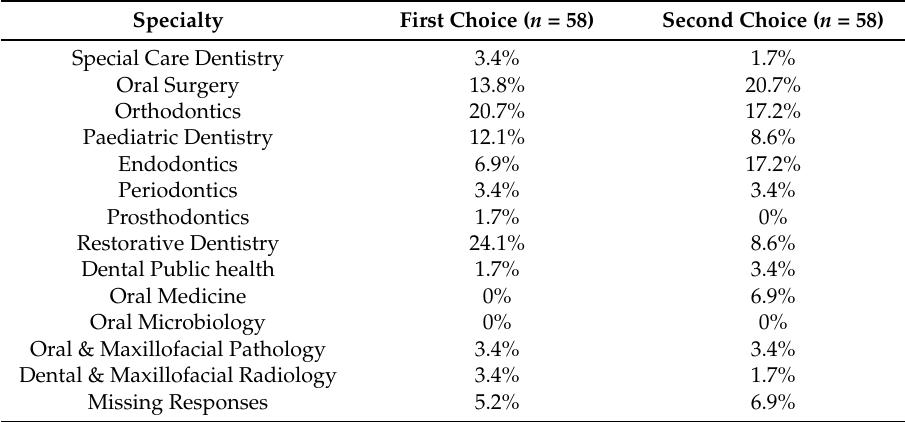
Table 4. First and second choices of specialty.